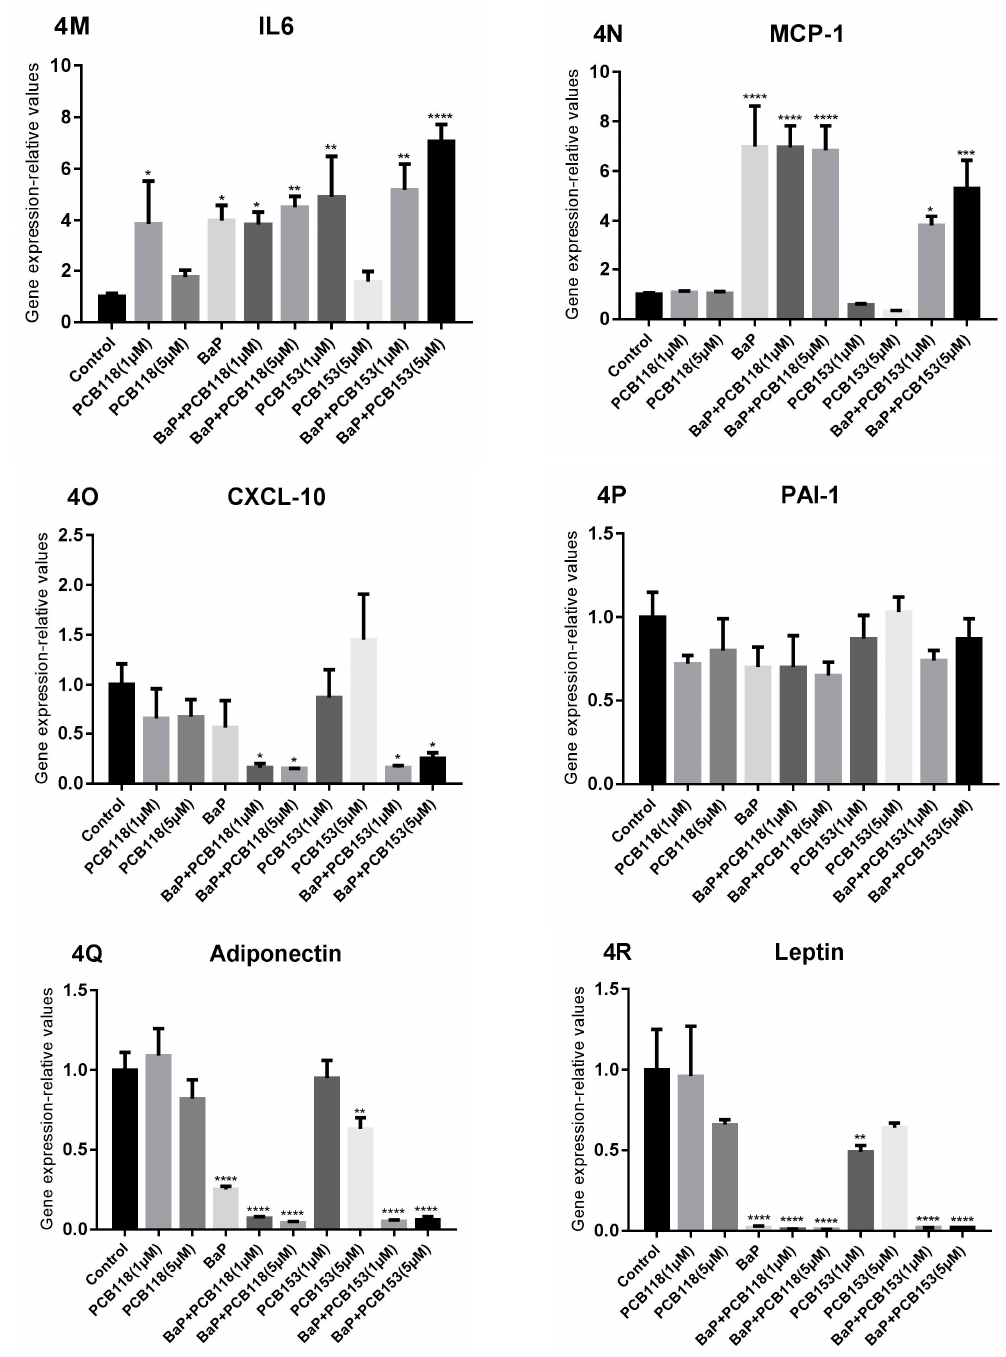
Figure 4. Effects of PCB118, PCB153 and BaP in “Time 1” conditions on the expression of genes related to adipocyte differentiation, glucose and lipid homeostasis, and inflammation. 3T3-L1 cells were incubated with or without PCB118 (one or five micromolars) or PCB153 (one or five micromolars) in the presence or not of BaP (one micromolar) according to the “Time 1” conditions described in materials and methods. Cells were washed twice with PBS and mRNA extraction and qRT-PCR were performed as described under materials and methods. Each incubation condition was carried out in quadriplicate and the experiment was repeated three times with similar results. The data are mean ± SD. The level of significance is given by comparison of treated trials with controls ( n = 4 per group): * p < 0.05; ** p < 0.01; *** p < 0.001; **** p < 0.0001.